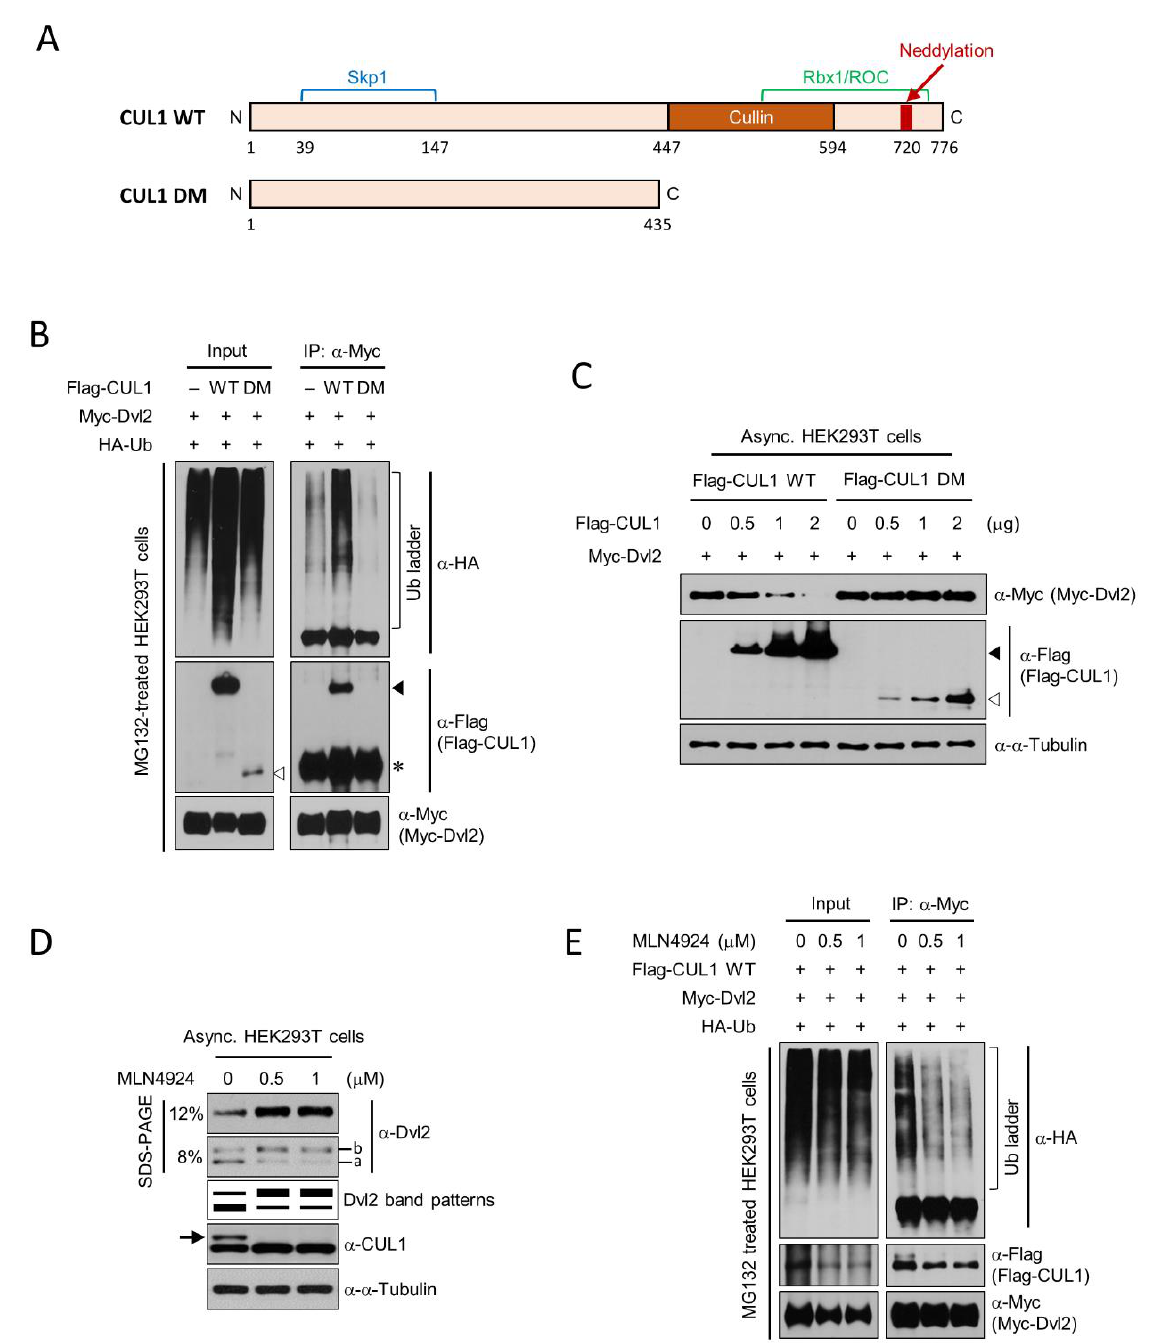
Figure 3. Neddylation-dependent CUL1 activation induces Dvl2 ubiquitination. ( A ) Schematic diagram of the domain structure of CUL1 WT and CUL1 DM (an inactive truncation mutant of CUL1) used in this study. The amino acid numbers, potential interacting proteins, and domain names are indicated. ( B ) Asynchronously growing HEK293T cells transfected with empty vector (-), pFlag-CUL1 WT (WT), or pFlag-CUL1 DM (DM) were cotransfected with pMyc-Dvl2 and pHA-Ub . The resulting cell lysates were subjected to IP with an anti-Myc antibody. The precipitates were separated in 6% SDS-PAGE followed by immunoblotting analysis with the indicated antibodies. The filled or empty arrowhead indicates the Flag-CUL1 WT or DM, respectively. Asterisk, mouse IgG heavy chain. ( C ) Different amounts of pFlag-CUL1 WT or DM plasmids were cotransfected with pMyc-Dvl2 into asynchronously growing (Asnyc.) HEK293T cells. The resulting cell lysates were subjected to immunoblotting analysis with the indicated antibodies. The filled or empty arrowhead indicates Flag-CUL1 WT or DM expression, respectively. A constant amount of total DNA was transfected into the cells. ( D ) Different